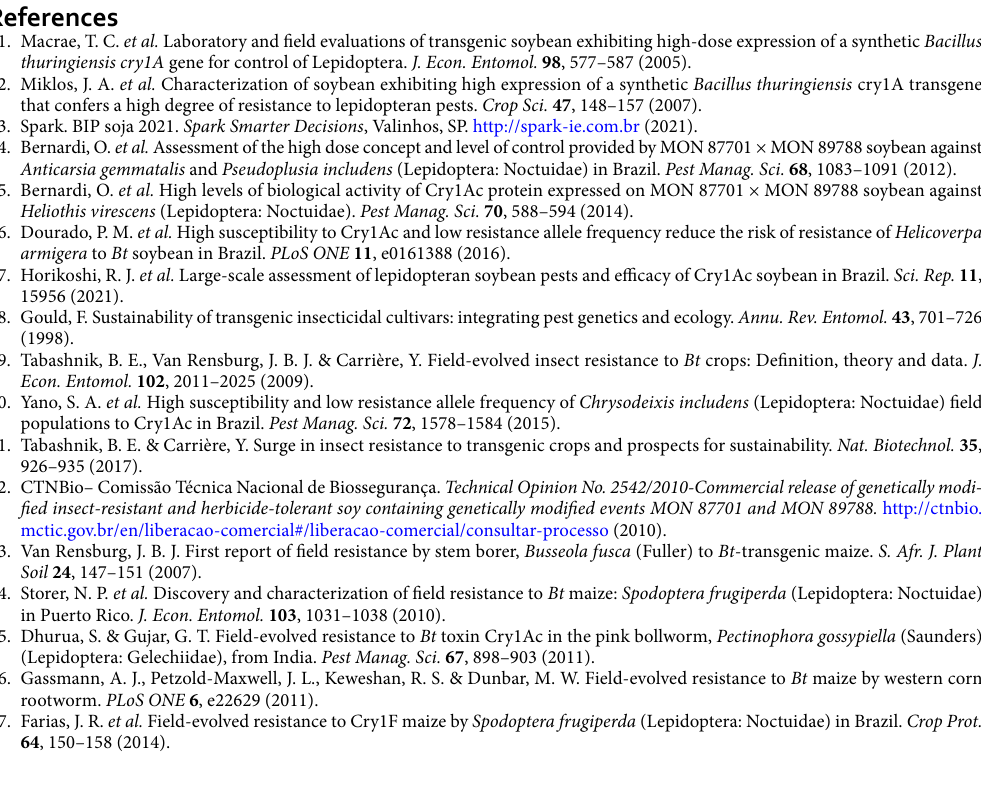
Figure 6. Relationship between adherence to structured refuge requirements and the adoption of MON 87701 × MON 89788 soybean across mesoregions ( A ) and crop seasons ( B ) in Brazil. Data on MON 87701 × MON 89788 soybean adoption and strict refuge compliance across mesoregions for the 2014/15 to 2019/20 cropping seasons were obtained from market research companies Kynetec (2014/15–2017/18) and Spark (2018/19–2019/20). The middle horizontal line within each box in ( B ) represents the median; the bottom and top edges of the boxes represent the 25th and 75th percentiles,